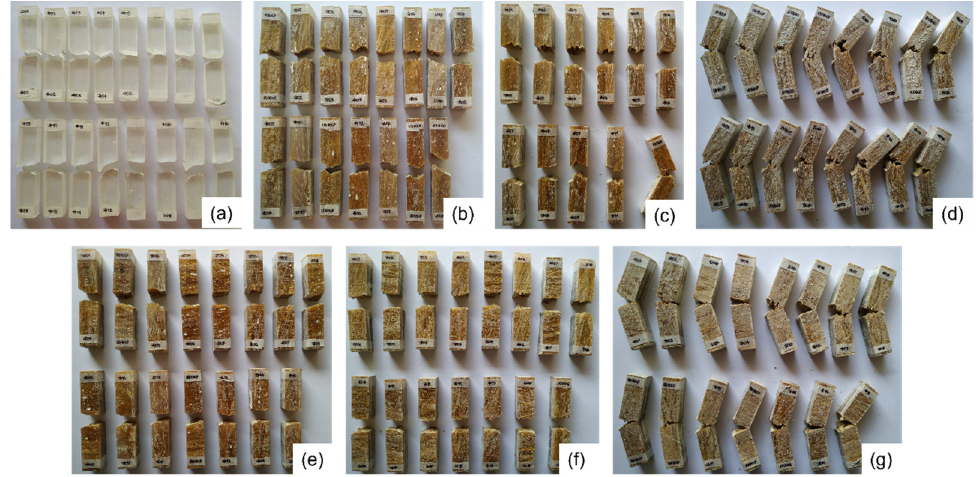
Figure 3. Groups of specimens containing 100% epoxy ( a ), unidirectional (UD) composites with 10% ( b ), 20% ( c ), and 30 vol.% of PALF ( d ); and bidirectional (BD) composites with 10% ( e ), 20% ( f ), and 30 vol.% PALF ( g ).